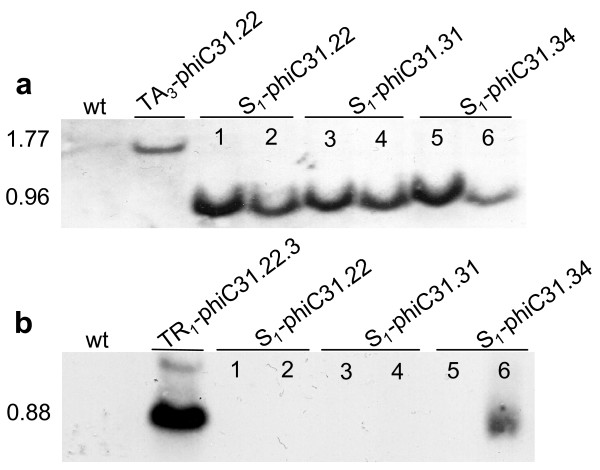
S1 plants examined by Southern blot analysis for excision and segregation of phiC31 gene. a) Genomic DNA cleaved with EcoRV hybridized with a 32P-labeled GUS1350 probe (Fig. 1). b) Genomic DNA digested with XhoI and hybridized with a 32P-labeled NPT690 probe. Plant lines (lanes 1, 2) S1-phiC31.22.3.18.1, 22.29.7.1; (lanes 3, 4) S1- phiC31.31.31.1.1, 31.31.13.1; (lane 5, 6) S1-phiC31.34.2.10.1; 34.9.20.1. Control lanes are wt (wild type Arabidopsis genomic DNA), TA3-phiC31.22, (target lines), TR1- phiC31.22.23 (phiC31 recombinase expression line).